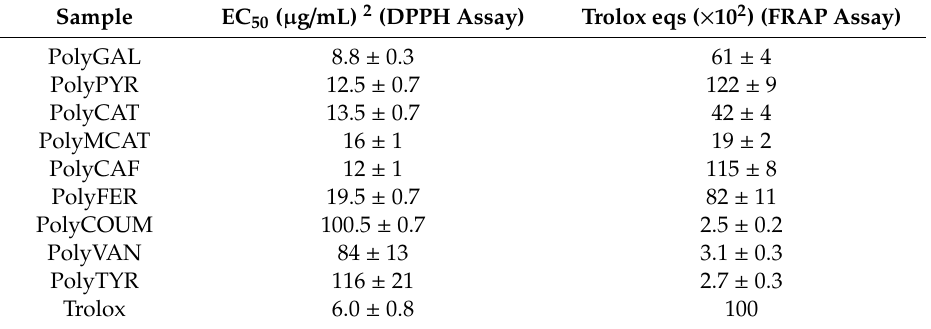
Table 2. Antioxidant properties of the acid-treated phenolic polymers 1